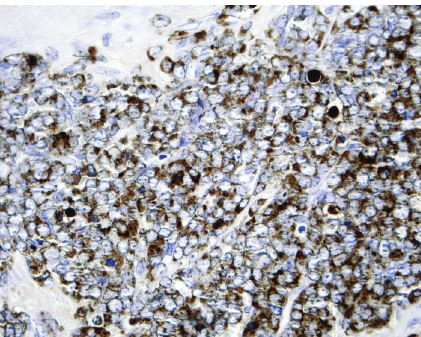
Figure 3: Abundant cytoplasmatic granules, positive for myeloper- oxidase. Myeloperoxidase